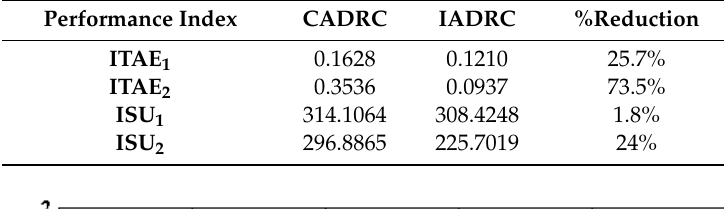
Table 3. Performance of the decoupled ADRC scheme [23].